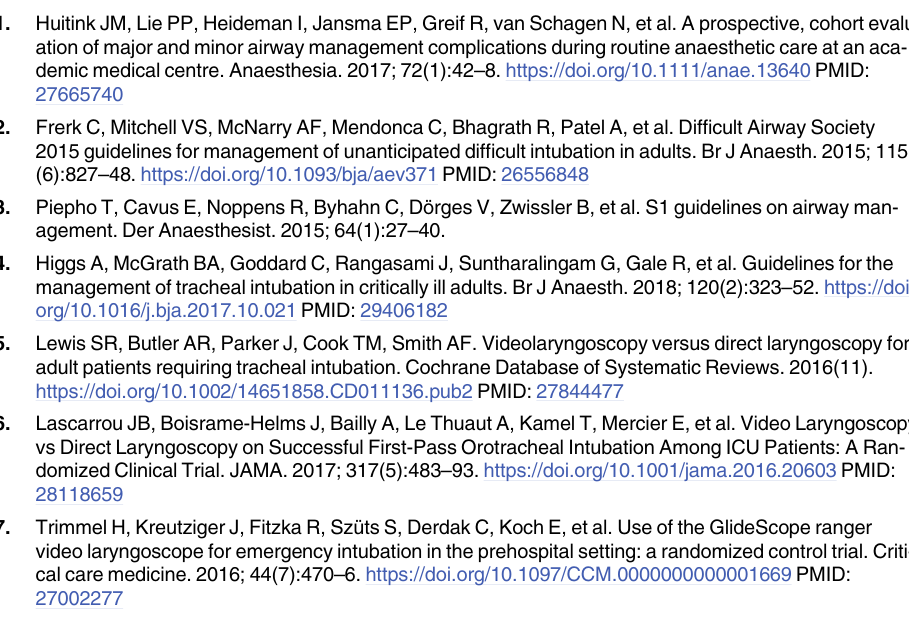
S1 Table. Raw dataset for intubation of difficult airway. S2 Table. Raw dataset for learning curve in a normal